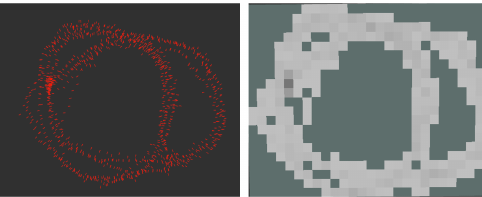
Figure 8. Example of grid map in the distribution-based evaluation. Arrows in the left figure are the pose of collected keyframes and the value of grid in the right figure is determined by the exploration score. Table 2. Parametric distribution with interval sampling, where the ideal one is regarded as an evaluation standard for completeness calculation. A series of parametric results are shown with different sampling intervals, and they are applied in our